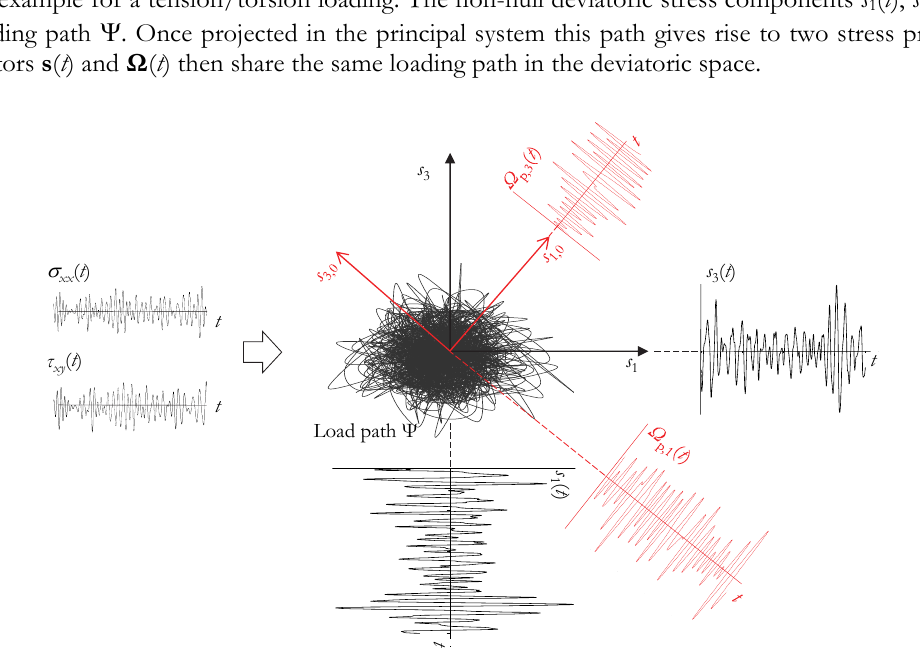
Figure 2: Example of random loading path  in the two-dimensional deviatoric space, resulting from a tension/torsion loading. The rotated “principal coordinate system” is located by axes ( s 1,0 , s 3,0 ) and it is used to obtain the stress projections Ω p,1 ( t ), Ω p,3 ( t